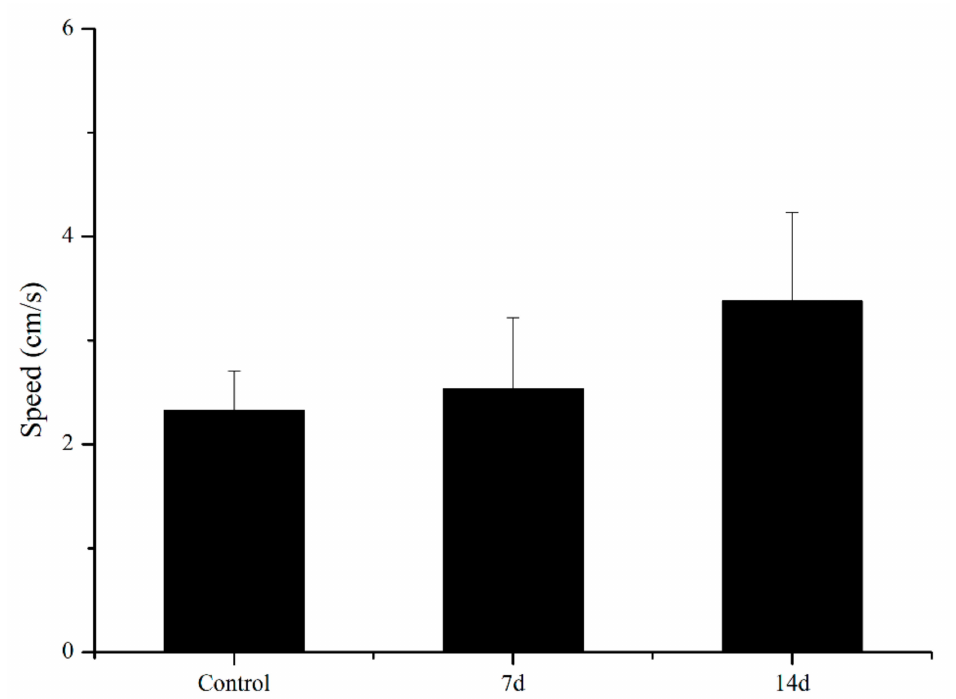
Figure 8. Effects of 7 and 14 days of the UCS protocol on speed in the rare minnow. Data are expressed as mean ± SE (n =